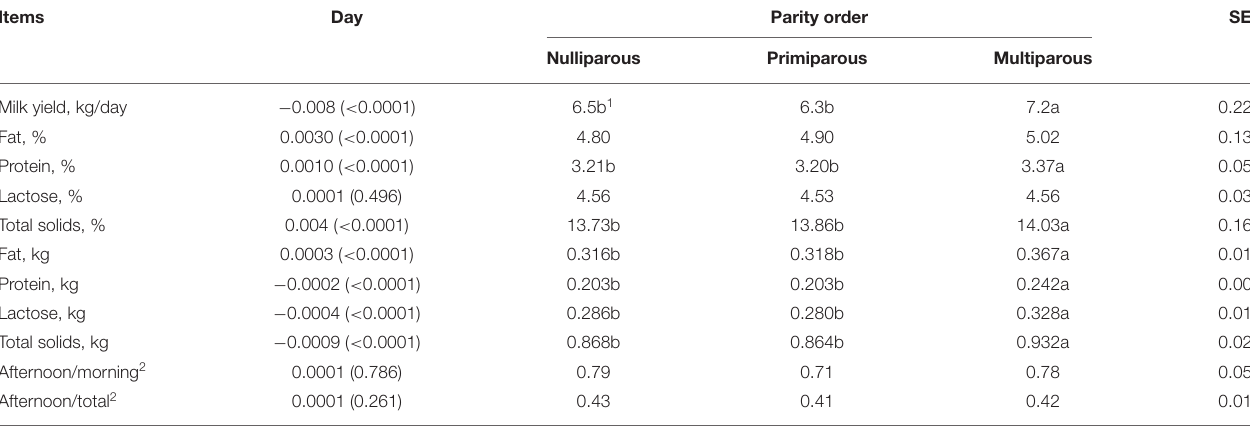
TABLE 2 | Regression coefficients for the covariate days in milk (with respective P -values), estimates of parity order effects and general standard error (SE).